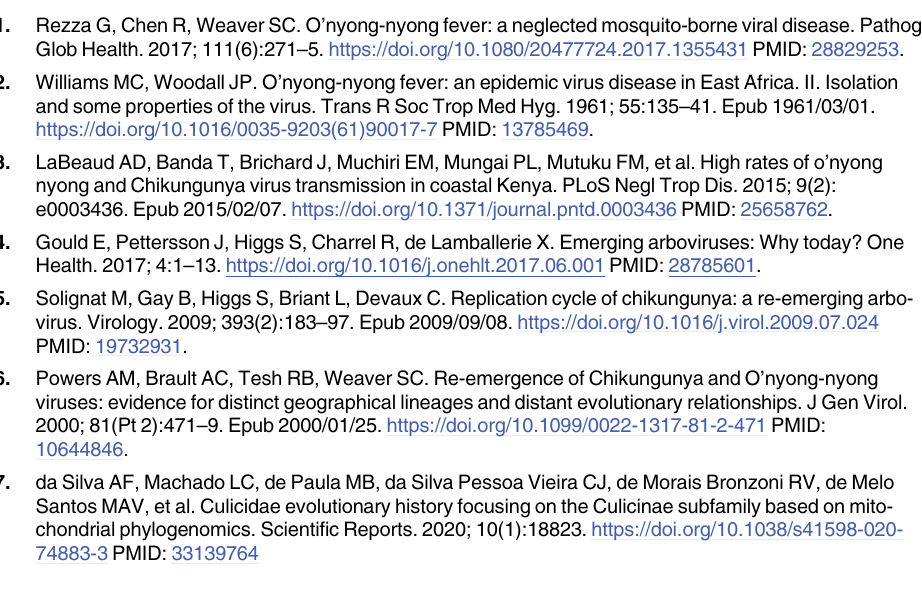
S1 Data. Excel spreadsheet containing the underlying numerical data for Fig